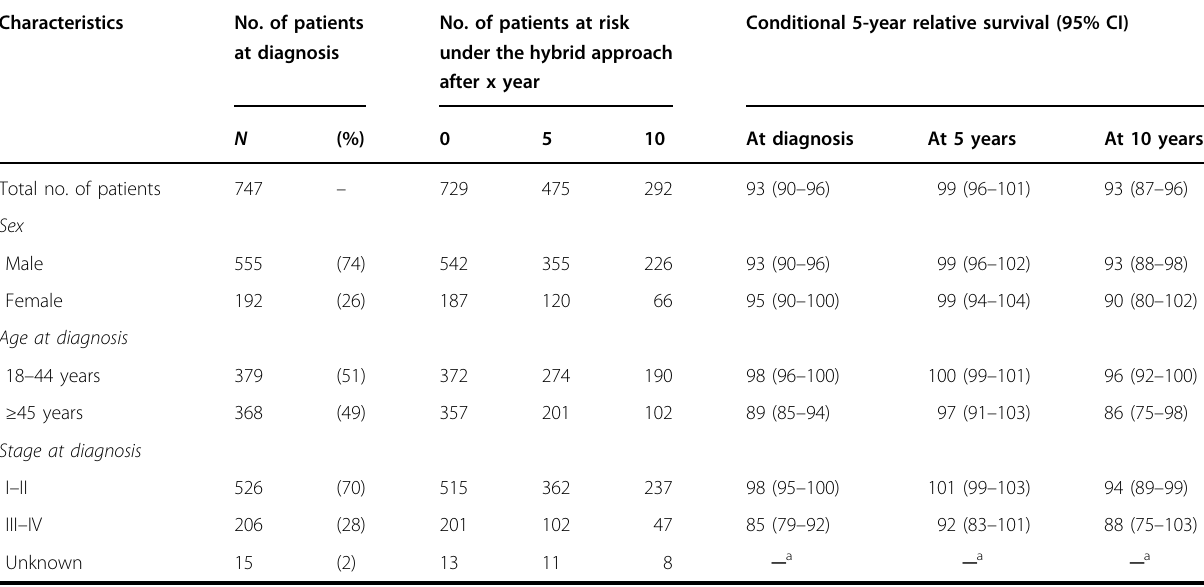
Table 1 Five-year relative survival at diagnosis and 5- and 10-years post-diagnosis among adult patients with nodular lymphocyte ‐ predominant Hodgkin lymphoma in the Netherlands according to baseline characteristics, 1993 – 2018.